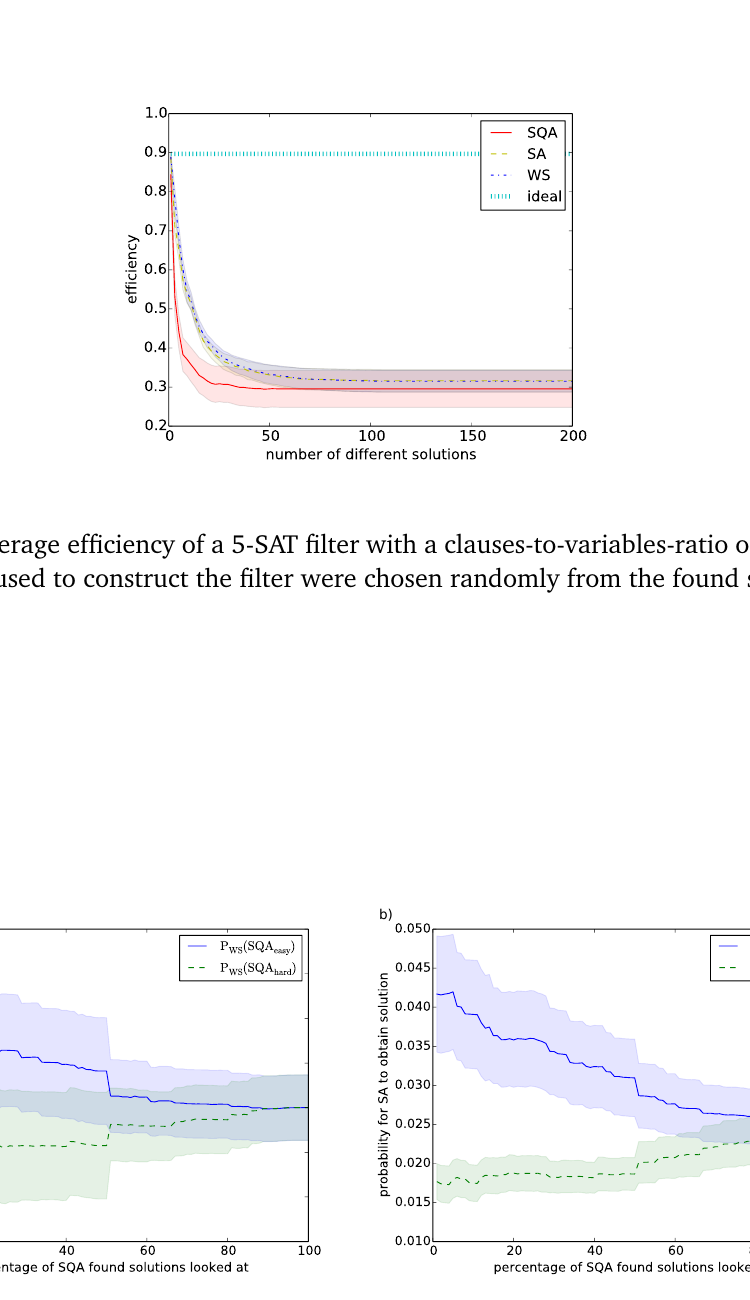
Figure 17: Probability for a) WS and b) SA to find the SQA-hardest and SQA-easiest solutions. The x-axis indicates the percentage of easiest and hardest SQA found solutions, running SQA 1000 times on 20 randomly generated 5-SAT instances with n = 48 variables and a clauses- ≈ 19.6. One instance, for which SQA did not find any solution, was to-variables-ratio of α χ 5 taken out of the statistic. An average was taken over the